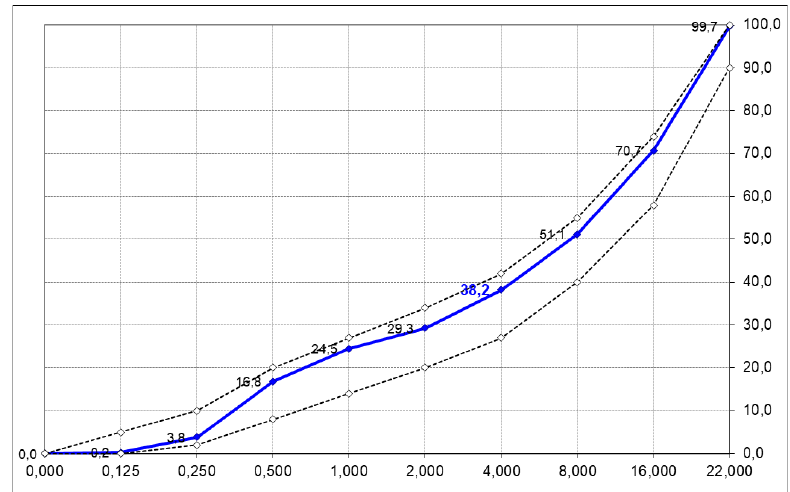
Figure 2. Mineral mixture grading curve.